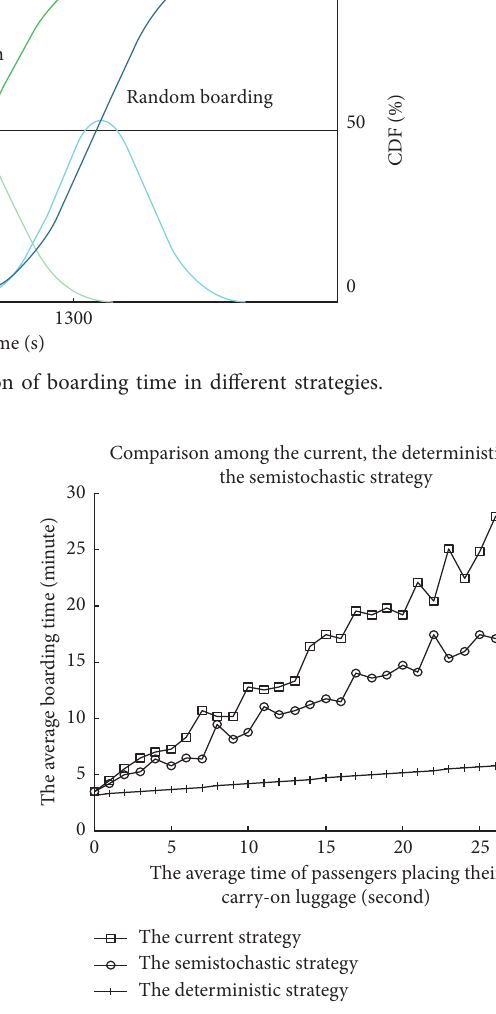
Figure 6: Comparison of boarding time in different